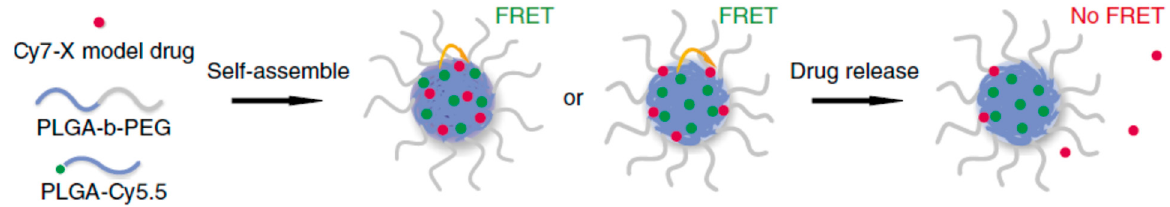
Figure 11. Schematic of the formation of Cy5.5-NP:Cy7-X FRET NP through self-assembly of PLGA(blue)–PEG(grey) block copolymer and Cy5.5(green)-conjugated PLGA in the presence of Cy7-X (red). Reproduced with permission from ref. [28]. Copyright 2016, the author(s).